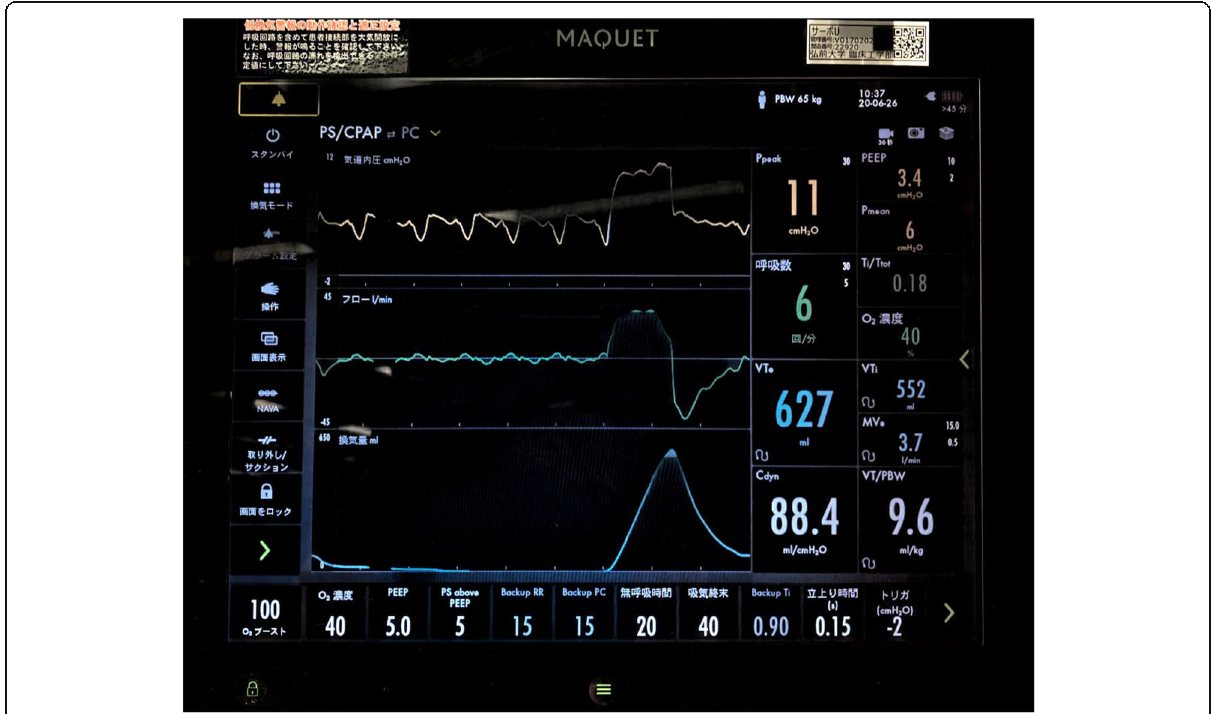
Fig. 3 The ventilator display during the second spontaneous breathing test with pressure triggering. Inspiratory pressure (up), flow (middle), and tidal volume (bottom) waveforms indicate low respiratory rate (6/min) with large tidal volume (627